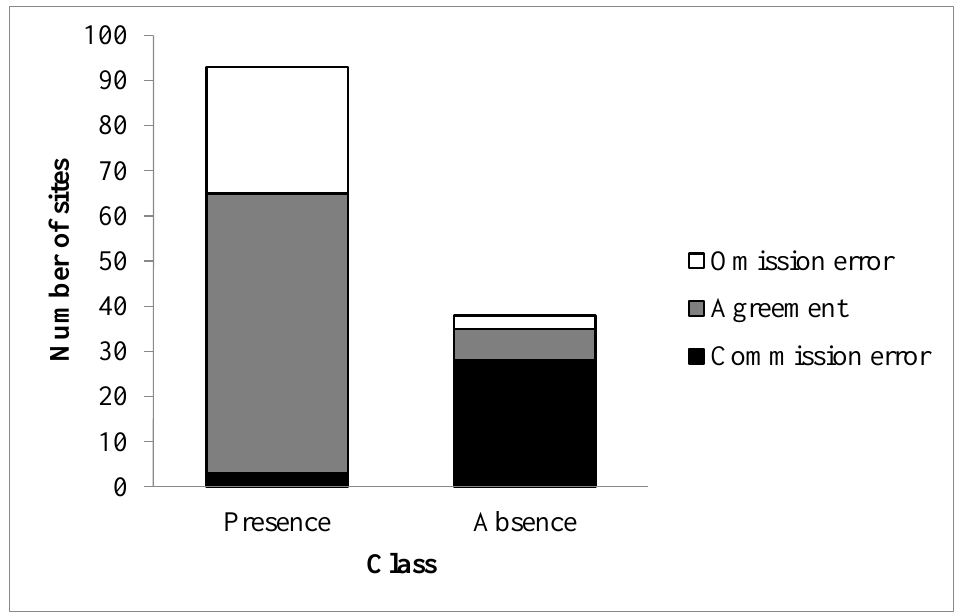
Figure 2. Omission and commission errors and agreement between predictions of glossy buckthorn occurrence from the phenology-based method and measurements from 100 plots (the number of validation plots (100) that correspond to the sum of gray and white only).